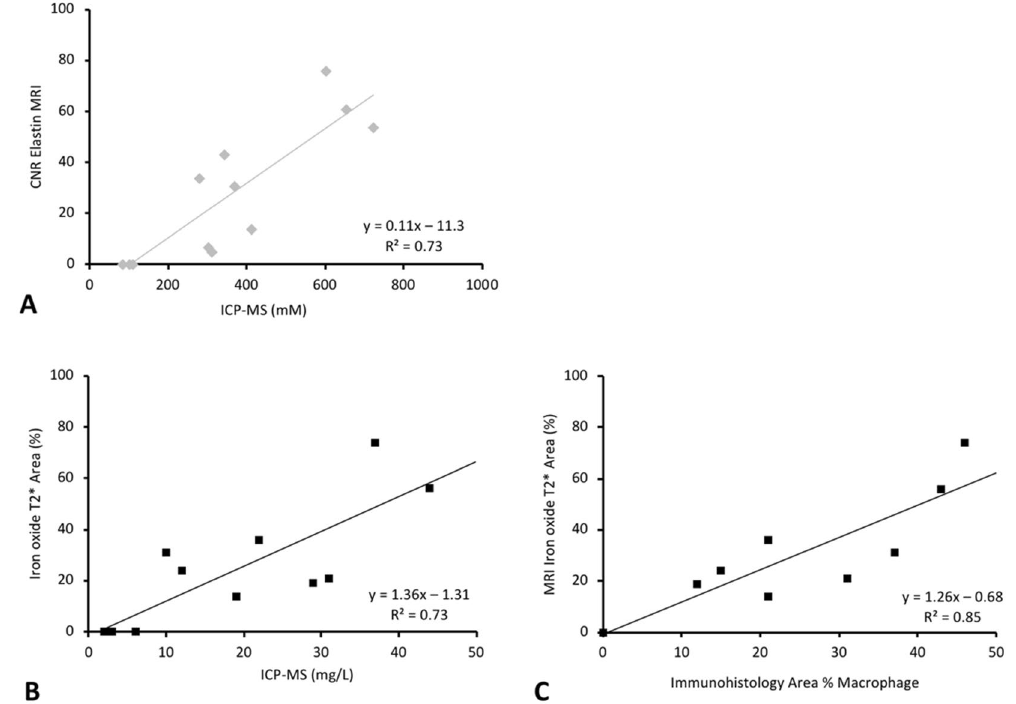
Figure 5. In vivo MRI signal measurements and ex vivo quantification of molecular probes. ( A ) The scatter- plots show a strong correlation between in vivo CNR and results from ICP–MS of brachiocephalic-arteries. ( B ) The scatter-plot shows a strong correlation between the signal-void on the T2 * -weighted-sequences with the results from ICP-MS. ( C ) The immunofluorescence-staining of the macrophage area using an antibody (CD68- Antibody) cause a strong correlation (p ≤ 0.05) with the signal-void on the T2 * -weighted-sequences.